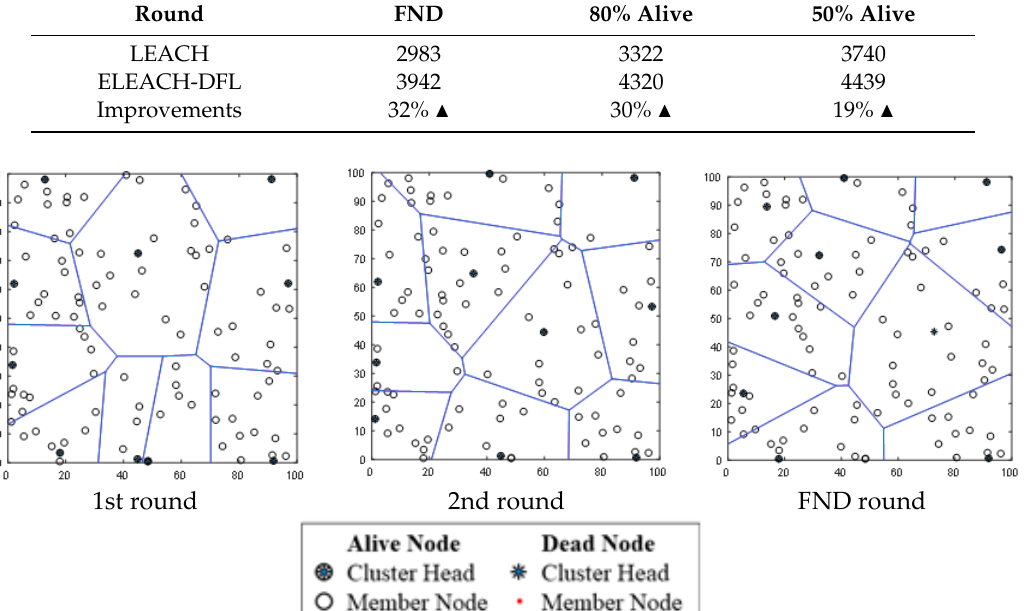
Table 7. Network lifetime comparisons between